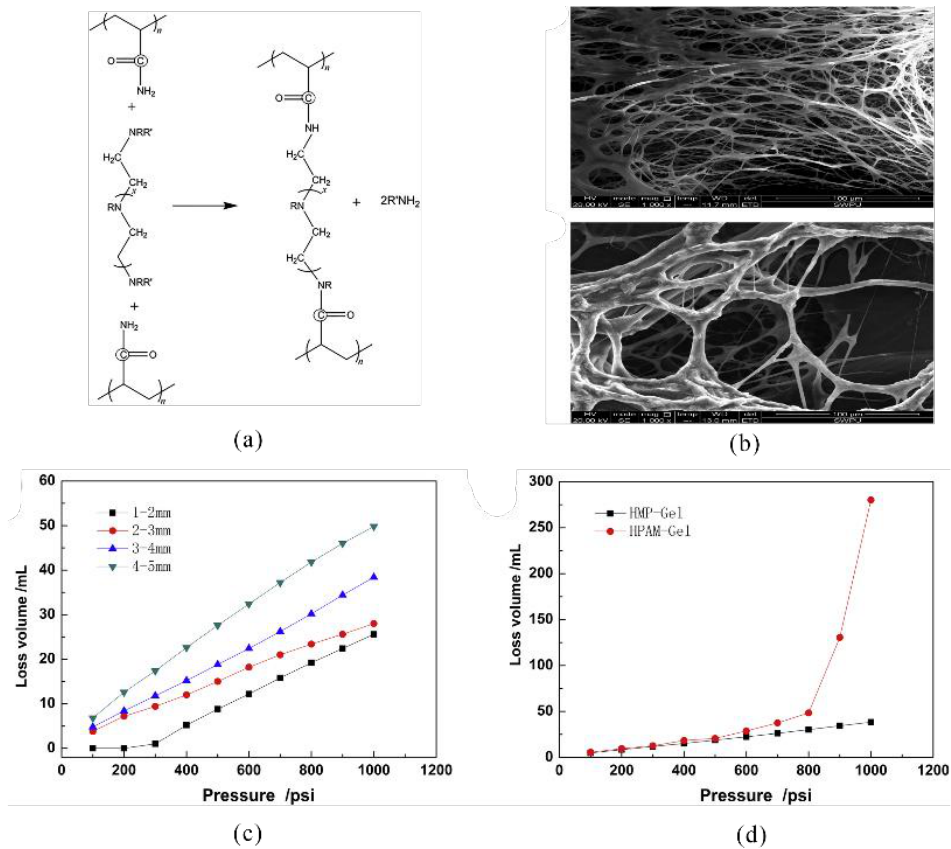
Figure 2. Mechanism and effect of the HMP-Gel as a lost circulation control agent. ( a ) The gelation mechanism of HMP-Gel; ( b )the microscopic morphology of the HMP-Gel; ( c ) the performance of the HMP-Gel for different size chips bed; ( d ) comparison of plugging performance of different gel. (Reprinted/adapted with permission from Ref. [32]. 2021, Xie, et al).